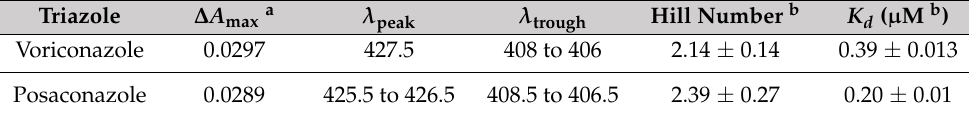
Table 3. Type II binding characteristics of triazoles to CnCYP51-6×His .